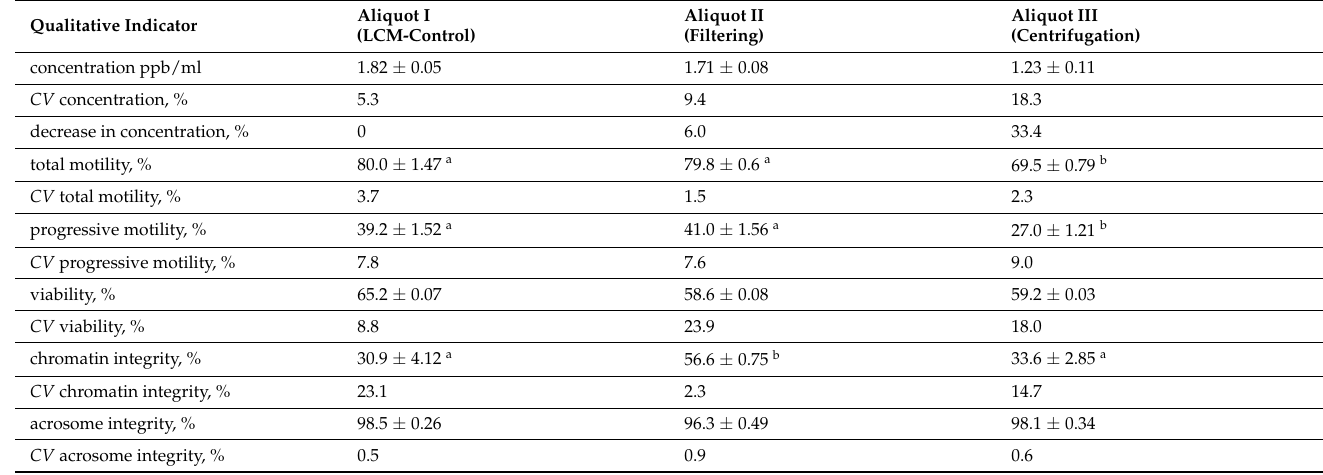
Table 2. Results of semen evaluation after storage for 3 h at 5 ◦ C (Mean ±